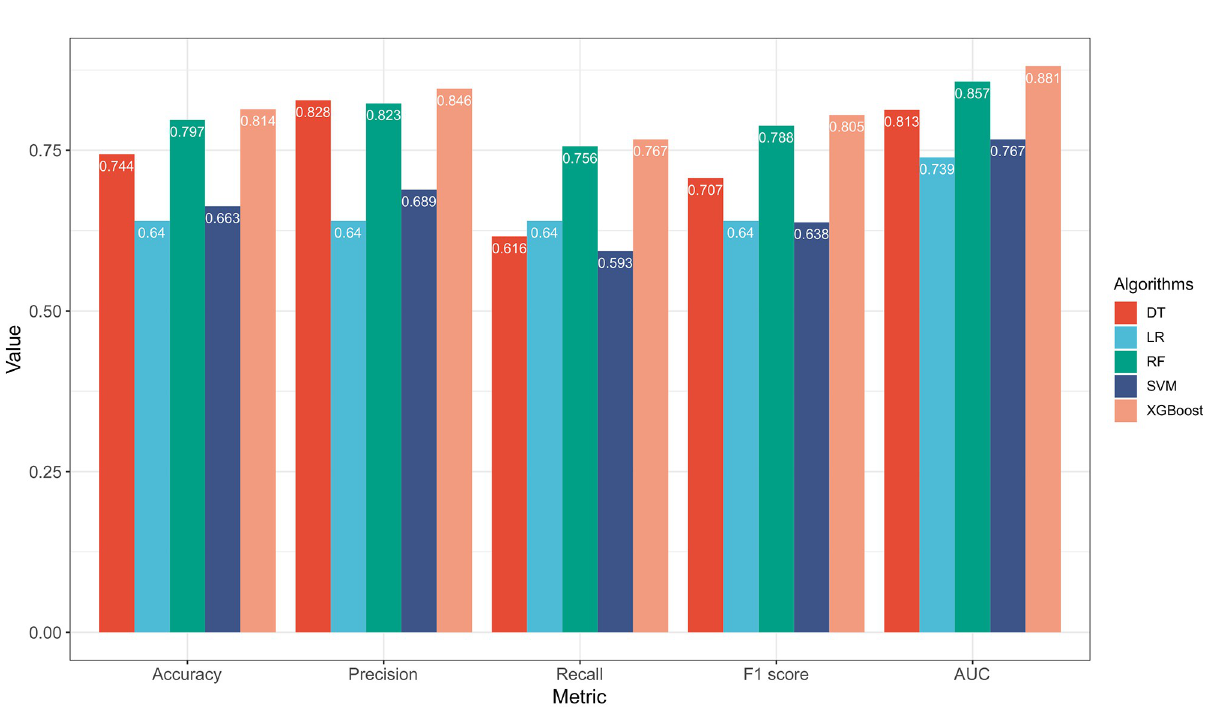
Fig 3. Performance comparisons of machine learning algorithms after over-sampling. Abbreviations : DT, Decision Tree; RF, Random Forest; LR, Logistic Regression; SVM, Support Vector Machine; XGBoost, extreme gradient boosting; AUC, area under the curve.